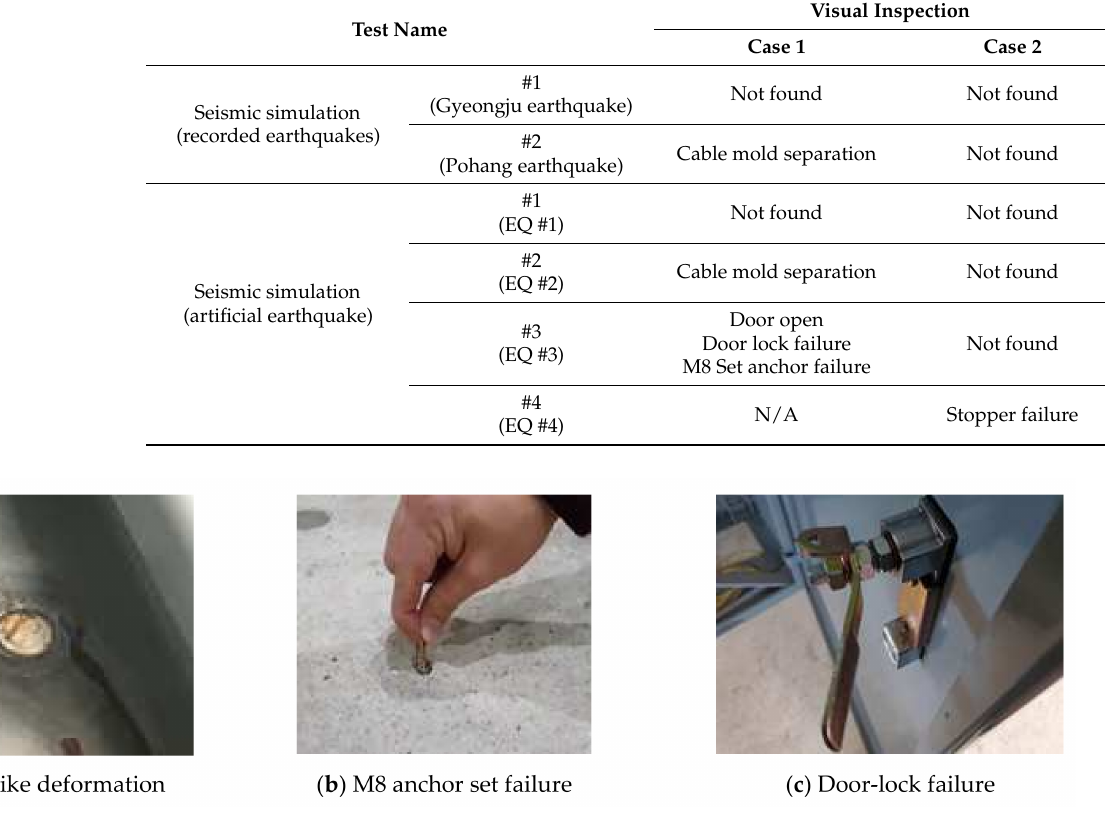
Figure 8. Failure of the RTU system due to EQ #3 for Case